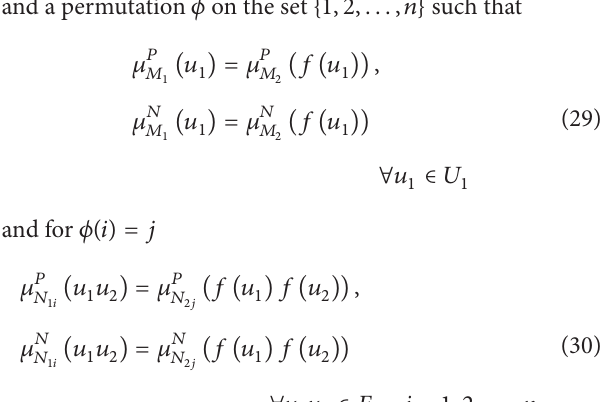
Figure 8: Isomorphic bipolar fuzzy graph